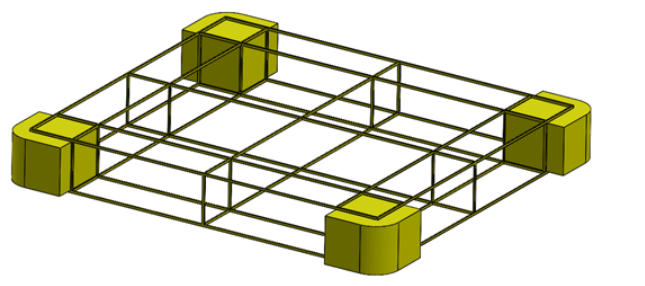
Figure 9. Floating foundation design. Table 2. Rectangular platform with polymeric floats